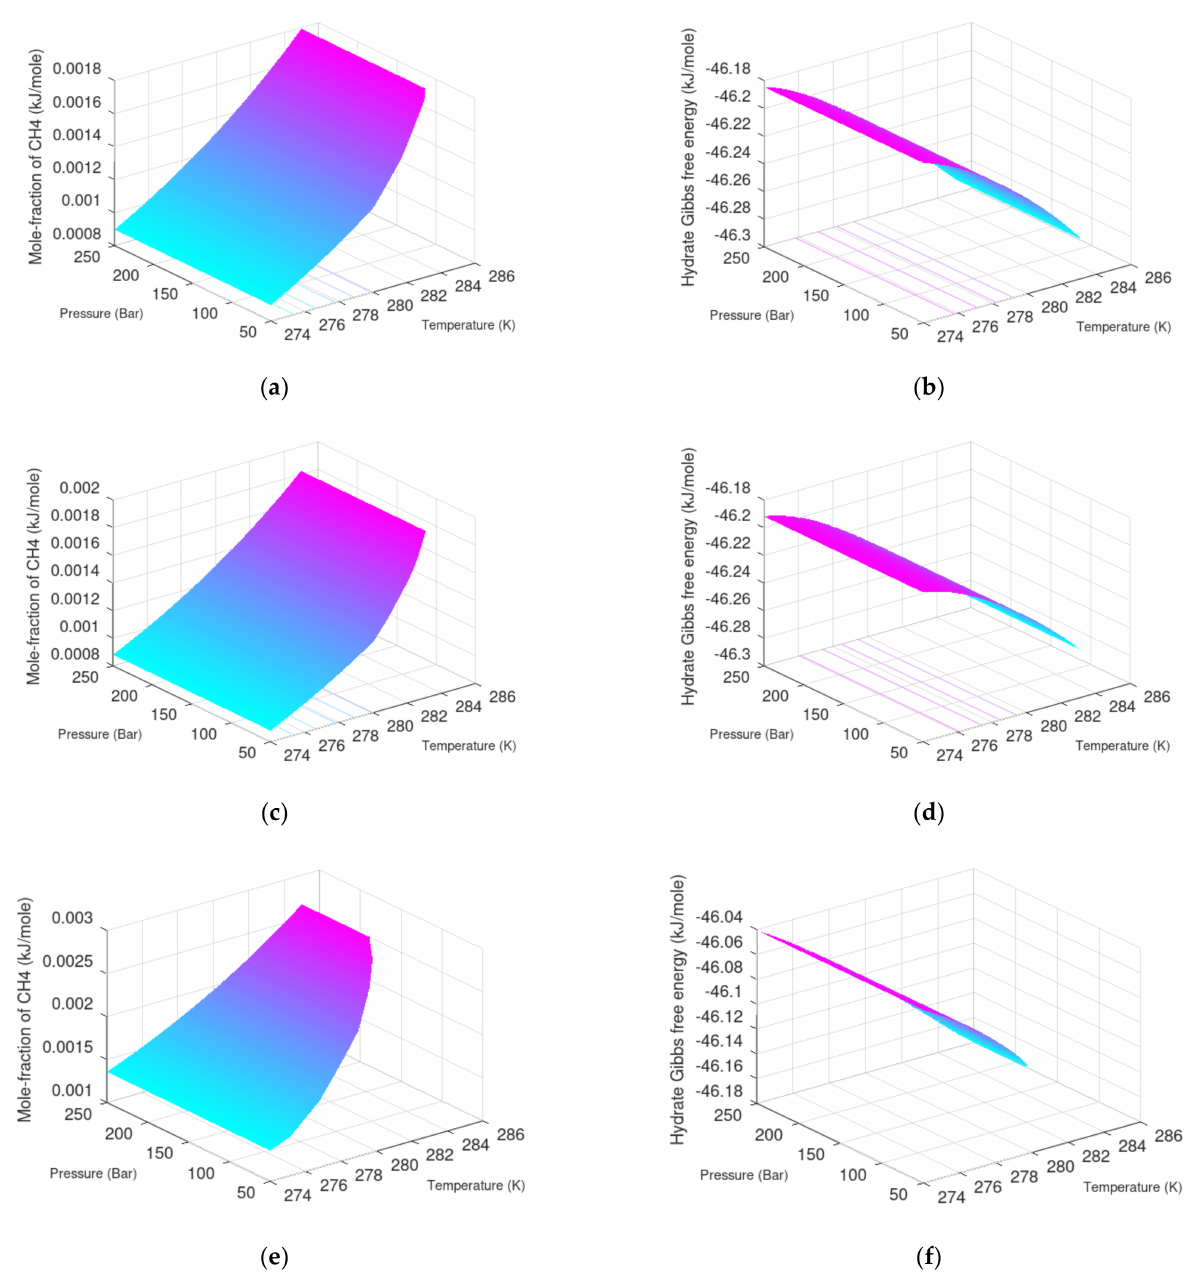
Figure 5. CH 4 hydrate stability limits ( a , c , e ) as function of concentration of CH 4 in surrounding liquid water and Gibbs free energy for the hydrate at stability limit ( b , d , f ). ( a , b ) are for pure water, ( c , d ) are for water with mole-fraction NaCl 0.0108, and ( e , f ) are for water with mole-fraction NaCl